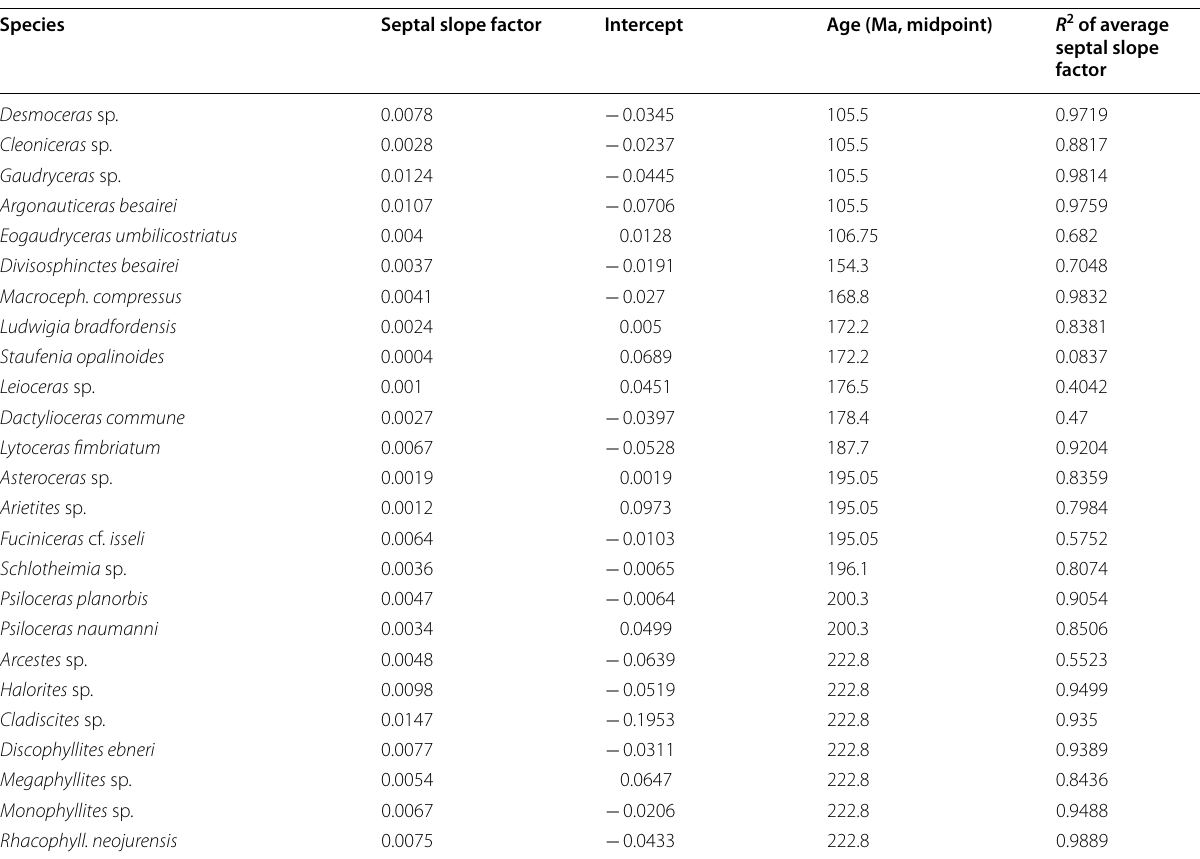
Table 4 Slope, intercept and R 2 -value of the average septal slope factor of 23 species corresponding to their geological age (average value of beginning and end of the corresponding stage after the ICS from 2020, Cohen et al., 2013). For the raw data see Additional